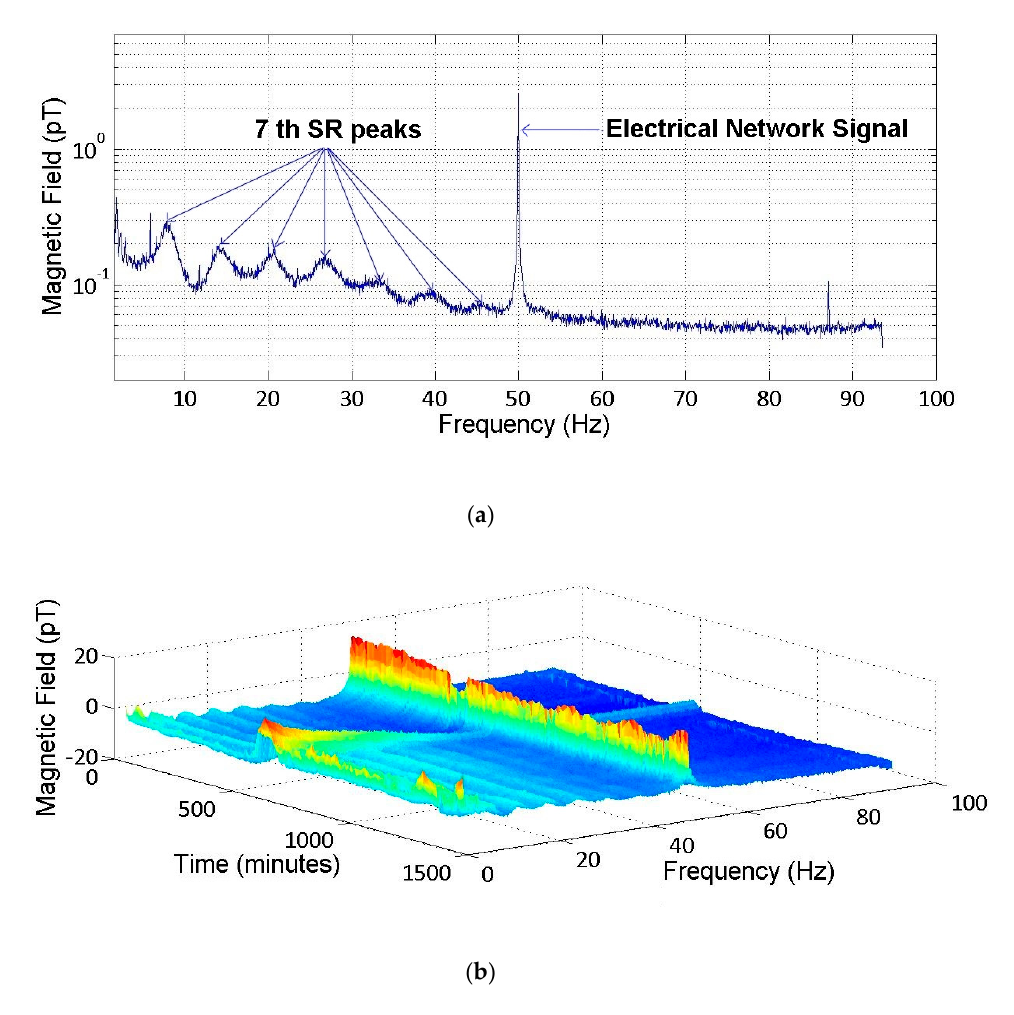
Figure 4. Data from the Calar Alto Sensor (Spain): ( a ) The 30 min periodogram. ( b ) The 24 h Spectrogram.